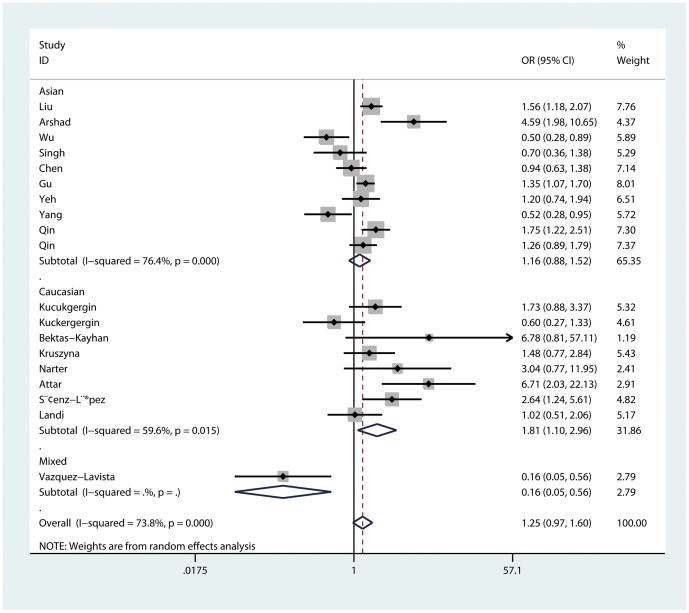
Forest plot of recessive model for overall comparison by ethnicity (GG vs. AG/AA).